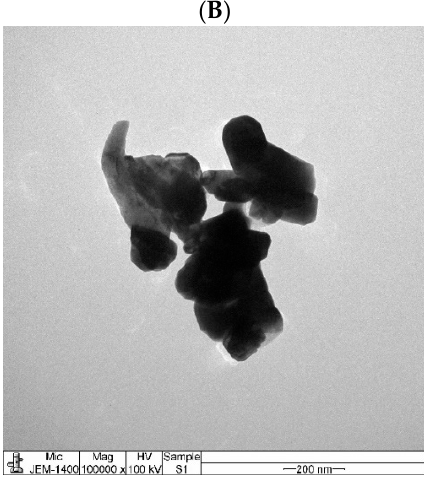
Figure 1. The ( A ) XRD pattern and ( B ) TEM image of Sr 2 PdO 3 prepared by the citrate-method, miller indices ( h, l, k ) are showed.